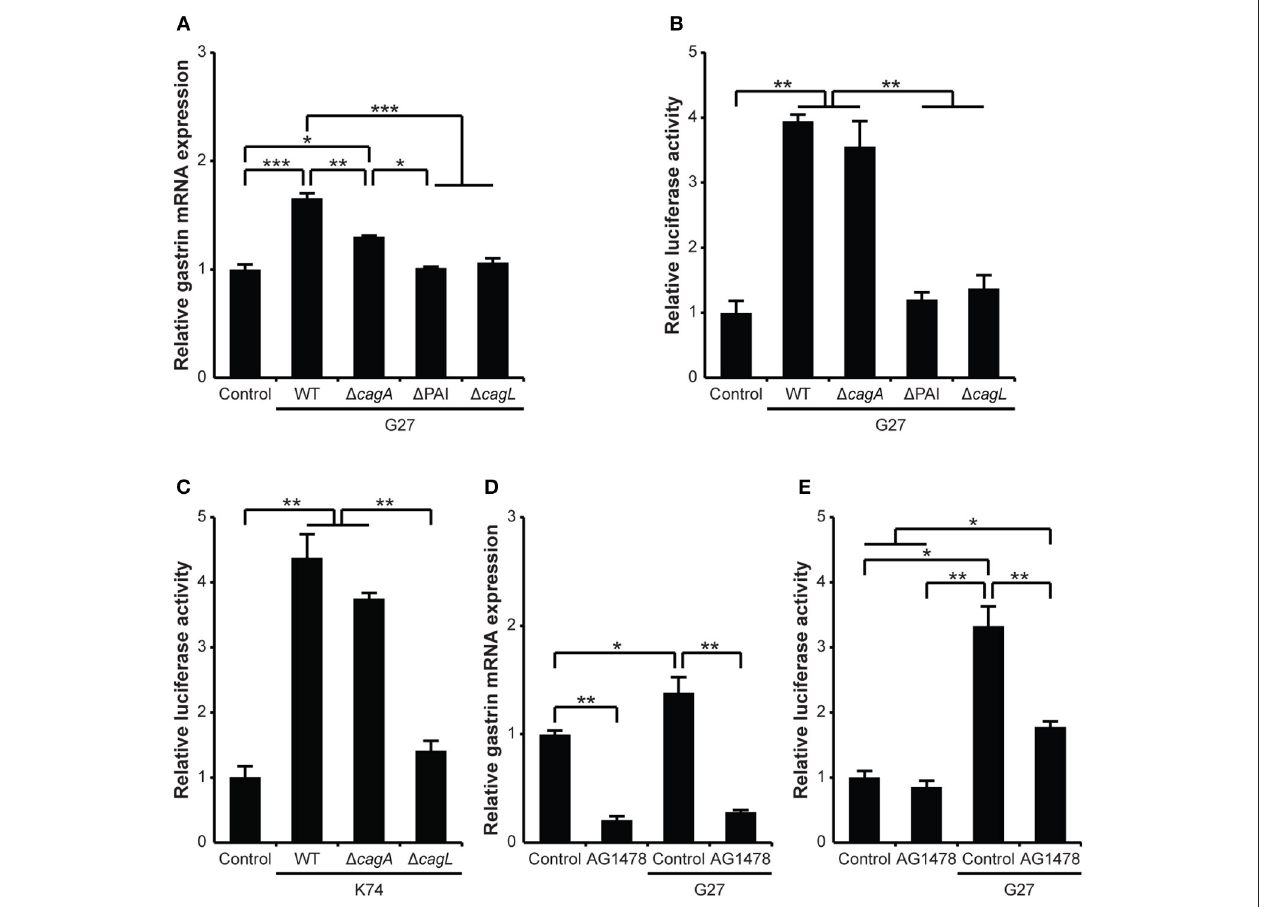
FIGURE 1 | H. pylori infection increases gastrin expression in gastric epithelial cells through the EGF receptor. (A) Gastrin mRNA expression was measured by qRT-PCR using RNA isolated at 5h after AGS cells were infected with H. pylori G27 WT or its isogenic mutant strains: G27 1 cagA , G27 1 PAI, and G27 1 cagL . The expression of gastrin mRNA was relatively quantified using the 2 − 11 Ct method. The expression of 18S rRNA was used as a reference. (B) G240-Luc cells were infected with G27 WT or its isogenic mutant strains: G27 1 cagA , G27 1 PAI, and G27 1 cagL . (C) G240-Luc cells were infected with Korean clinical isolate K74 or its isogenic mutant strains: K74 1 cagA and K74 1 cagL . (D) G240-Luc cells were pretreated with AG1478 (1 µ M) for 30min and infected with G27 WT. Five hours post infection, luciferase activity was measured and presented as a relative ratio to that of uninfected control cells. (E) Gastrin mRNA expression was measured by qRT-PCR using RNA isolated at 5h after AGS cells were infected with H. pylori G27 WT, with or without pretreatment of AG1478 (1 µ M) for 30min. Each result is presented as mean values ± standard deviation ( SD ) for three separate experiments, each of which was performed in triplicate. * P < 0.05, ** P < 0.01, *** P < 0.001.